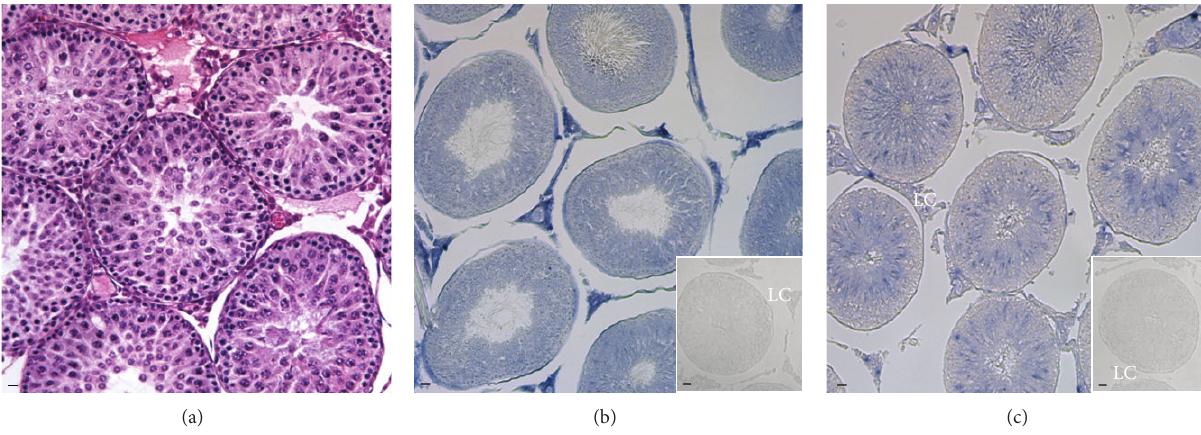
Figure 2: Section of adult R. norvegicus testis analyzed by hematoxylin-eosin staining (a) as well as by in situ hybridization for Gnrh1 (b) and Gnrhr1 (c) treated with antisense ((b), (c)) and sense ((b), (c) insets) probes. Localization of Gnrh1 and Gnrhr1 was observed in the interstitial Leydig cells (LC) and inside the seminiferous tubule. Scale bars: 20 𝜇 m. The results are representative of one of three assays.